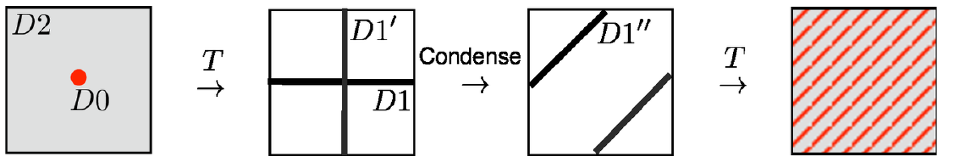
Figure 3. T-duality picture of bound state formation.